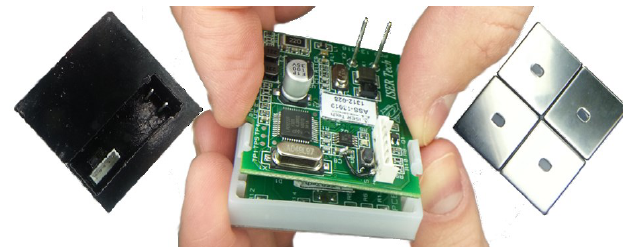
Fig. 12. Final prototype assembly with the plastic cases developed with a 3D printer. On the right the four tactile metal switches.